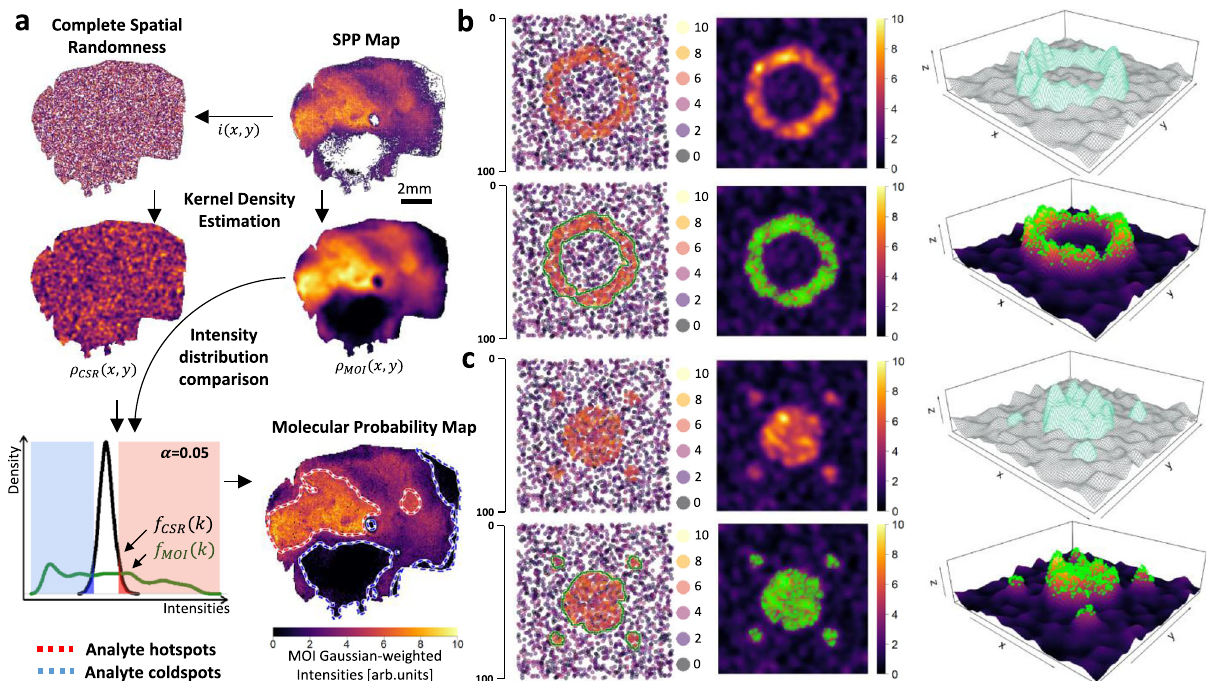
Fig. 2 | Computational molecular probabilistic map (MPM) work fl ow and identi fi cation of ground- truth in simulated datasets. a MPM computational work fl ow. A corresponding complete spatial randomness (CSR) model is created foreachmetabolite-of-interest ’ s(MOI)spatialpointpattern(SPP)withequalspatial pointdensity. Kernel density isestimated forboth, thusresulting inspatialdensity functions, ρ MOI x , y ð Þ and ρ CSR x , y ð Þ . The intensity distribution function f CSR k ð Þ , which converges to a normal distribution (Supplementary Fig. 12), then serves as the null distribution based on which null-hypothesis testing is carried out for each pixel intensity in ρ MOI x , y ð Þ with a signi fi cance level α of 0.05. MPM hotspots (red/ white contours) and coldspots (blue/white contours) are accordingly de fi ned as locations where the null hypothesis is rejected for the upper or lower-tail Benjamini – Hochberg corrected P -values (Supplementary Fig. 9), thus signifying areas of signi fi cant MOI relative spatial abundance and de fi ciency,